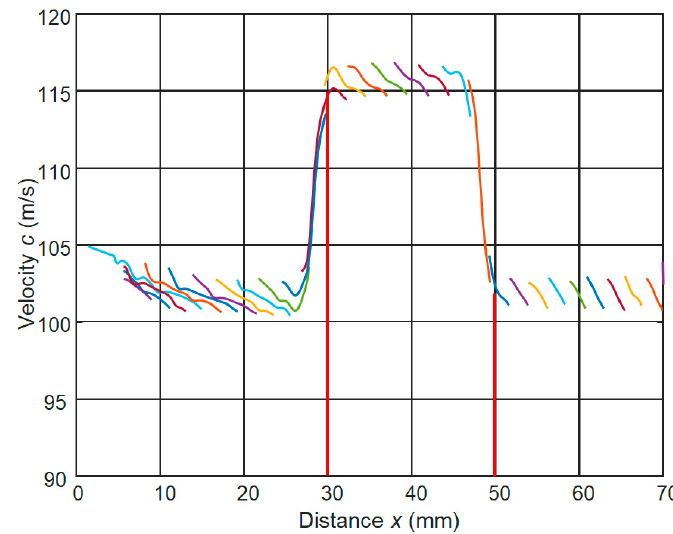
Figure 7. Spatial distributions of the A 0 mode velocity along B-scan across the rectangular darker zone of the simulated mica sample. The di ff erent colours correspond to the results obtained from di ff erent zero-cross lines in Figure 9.